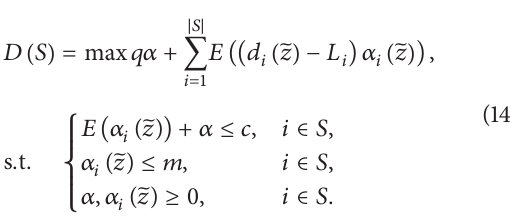
Table 1: The relationship between support and the optimal value.